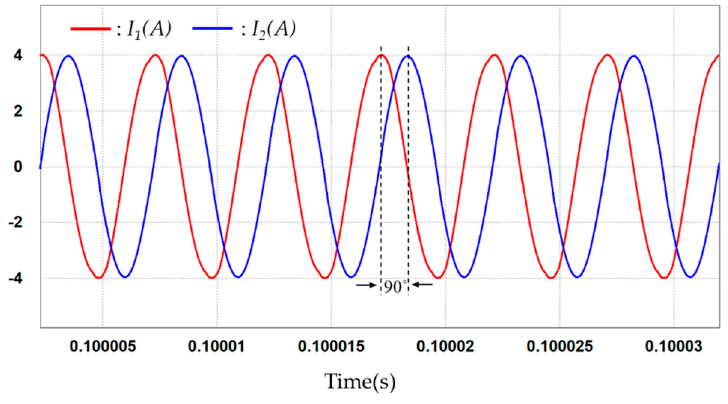
Figure 10. Simulated result: transmitter currents. Energies 2020 , 13 , x FOR PEER REVIEW